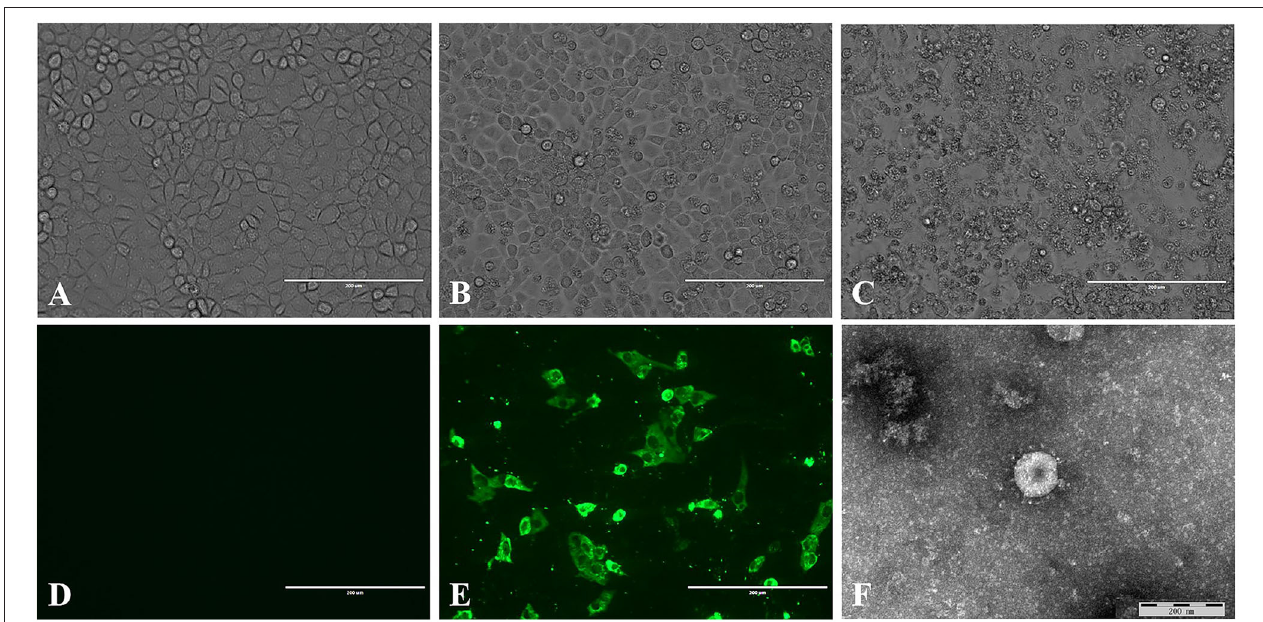
FIGURE 1 | Isolation and identification of the TGEV HQ2016 strain. (A) Control (uninfected) PK-15 cells. (B) Cytopathic effect (CPE) induced by TGEV HQ2016 after infected 24h in the PK-15 cell line. (C) Cytopathic effect (CPE) induced by TGEV HQ2016 after infected 36h in the PK-15 cell line. (D) IFA identification of control